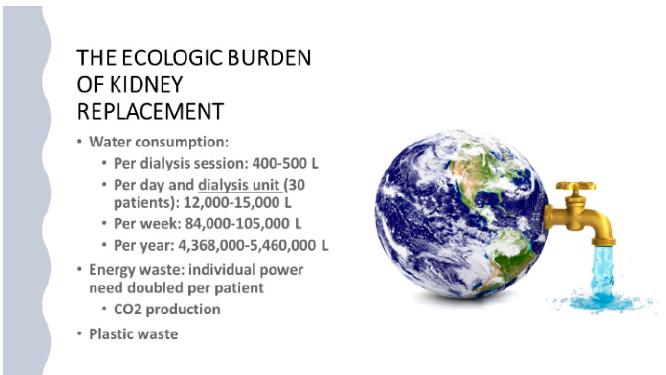
Figure 1. Summary of the main environmental problems related to hemodialysis. Graphic reprinted with permission from Depositphotos™, 2022 (https://depositphotos.com, accessed on 8 July 2022). A recent policy paper by the European Kidney Health Alliance (EKHA) was drafted by a group of concerned physicians, patients, nurses, engineers and chemists [1]. This text, next to other publications by the EKHA, intends to create awareness among European policy makers of the dimensions of the environmental burden of nephrology [1,6]. It also wants to motivate the nephrological community, both from the manufacturer and provider sides, to take this problem to heart and avoid European nephrology lagging behind compared to other European economic sectors or to the nephrology field in other continents.